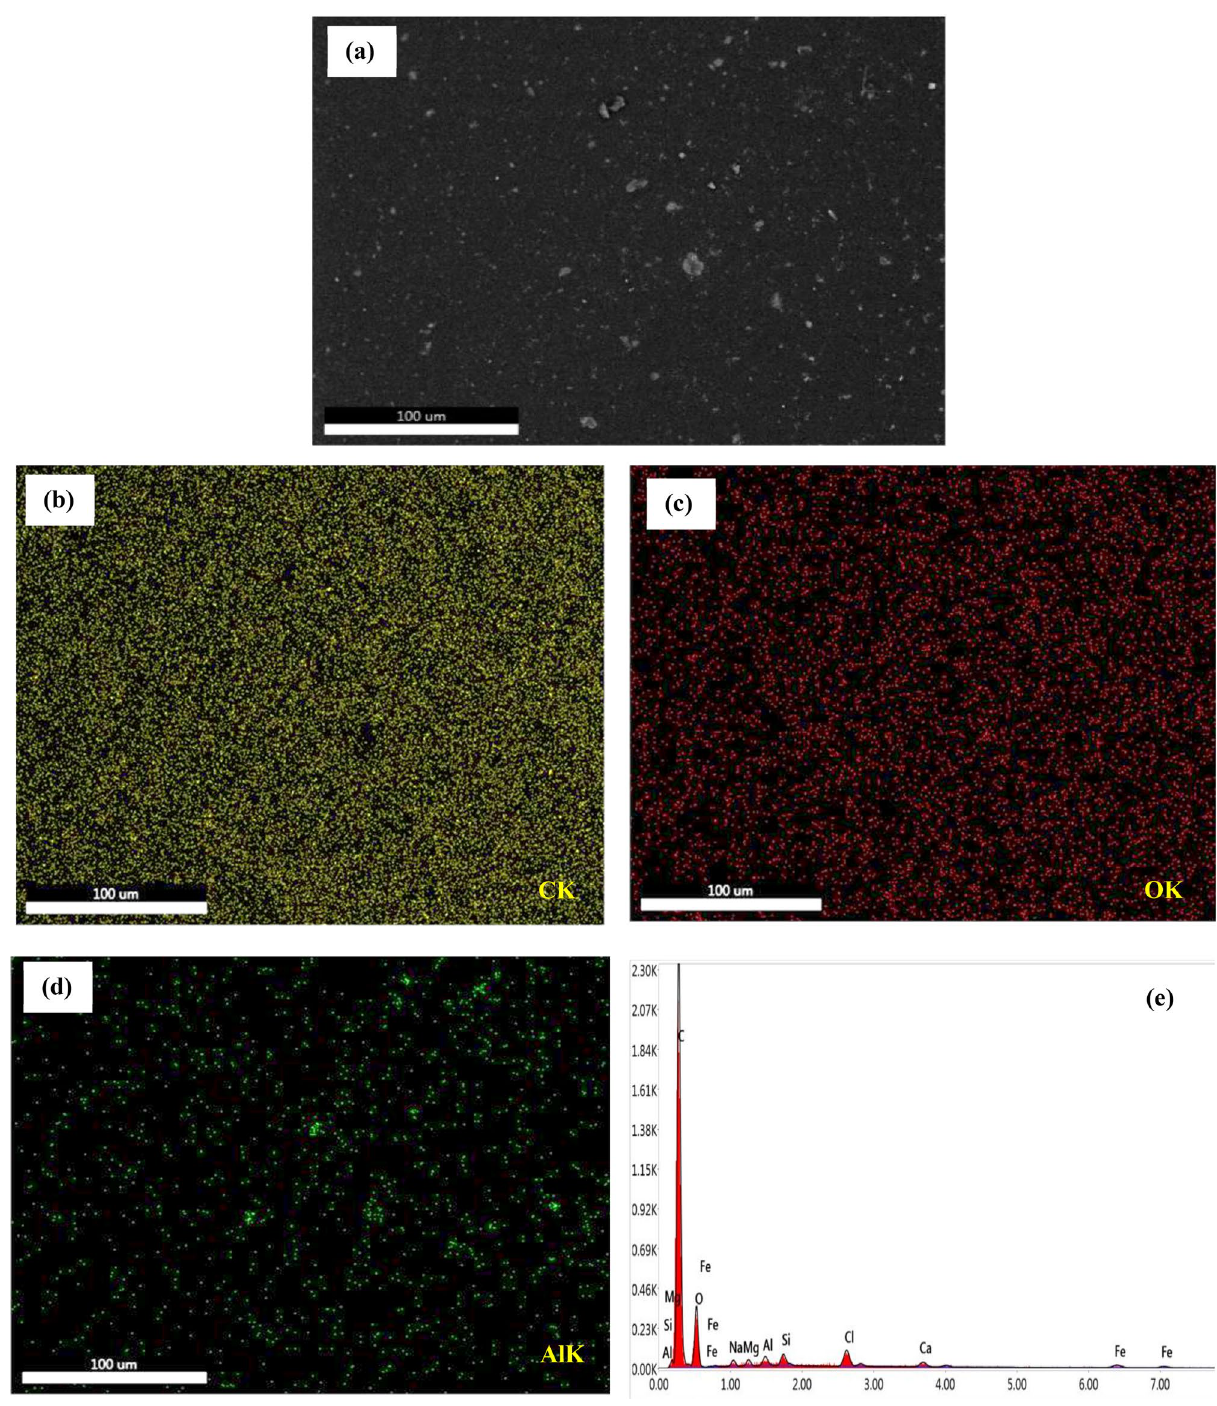
Figure 11. ( a ) FE-SEM of stepwise graded nanocomposite coating N123, ( b )–( d ) elemental map, ( e ) EDX